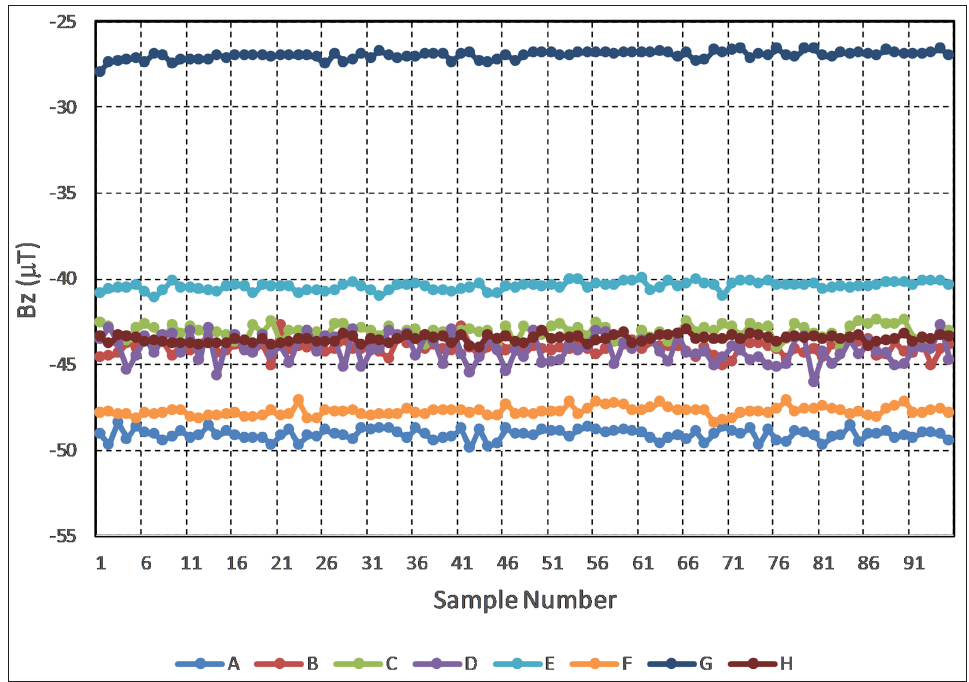
Figure 4: Samsung phone data showing dissimilar measurement values under identical conditions. Plot symbols A–D are for the four Samsung Galaxy 8S phones. Symbols E–H are for the Samsung Note 5